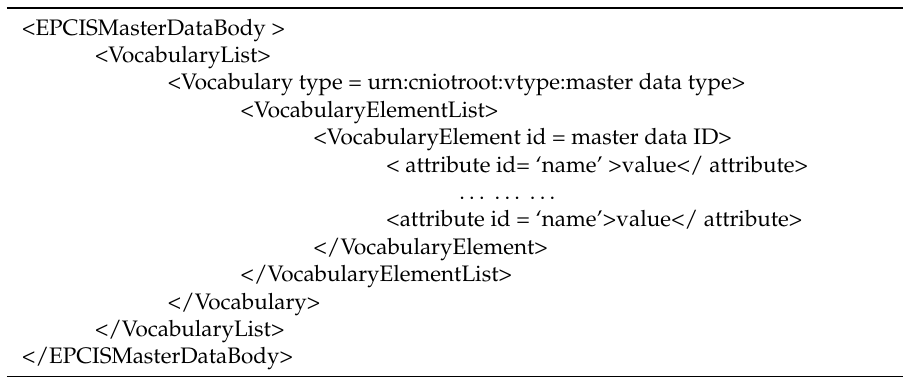
Table 2. EPCIS master data structure.